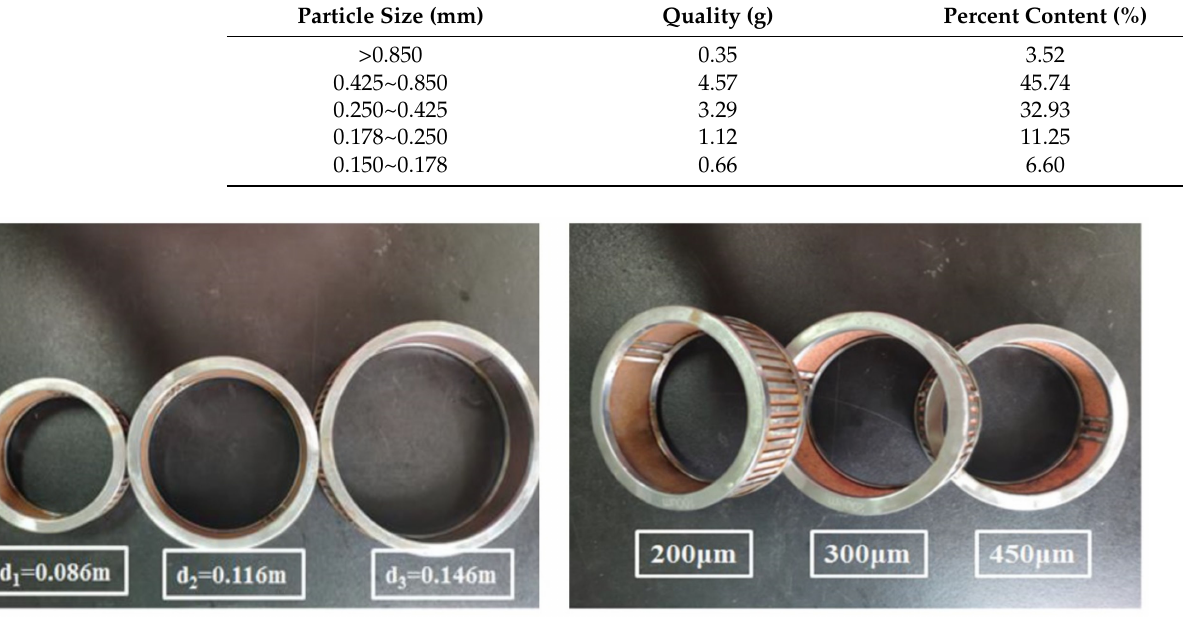
Figure 6. Physical diagram of mass transfer ring.